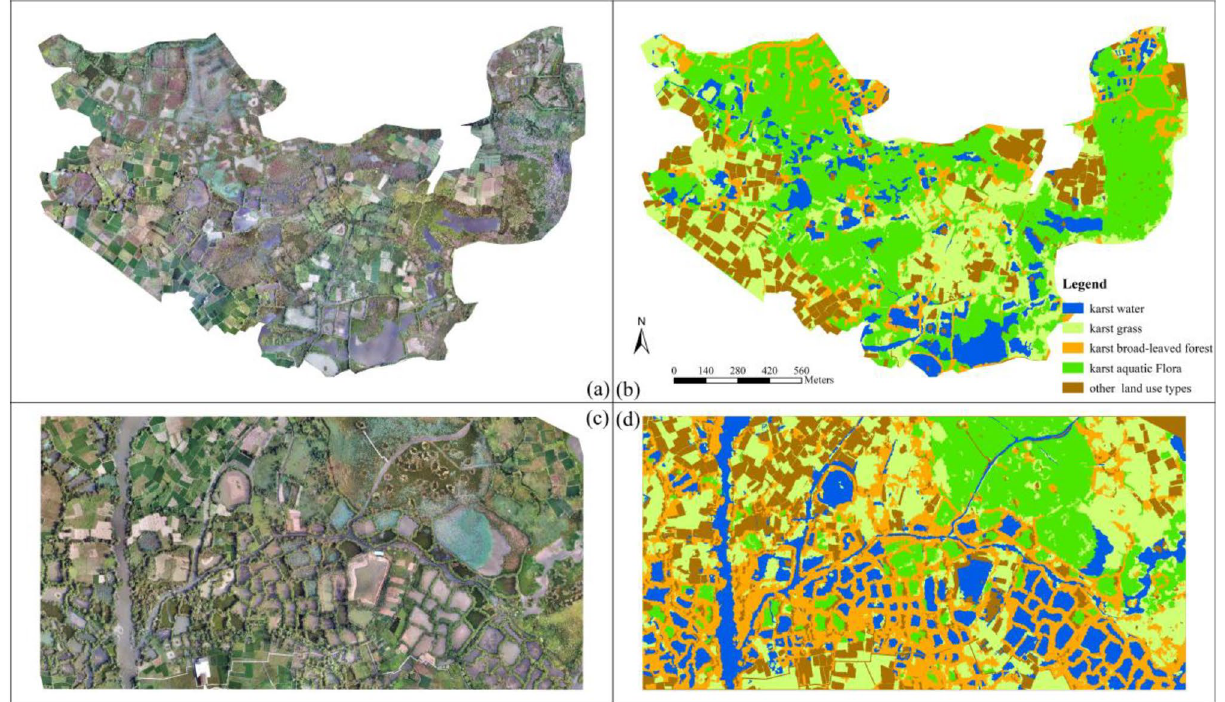
Figure 3. The semantic labeling dataset for SegNet classification ( a ) DOM image of area A. ( b ) semantic labeling dataset of Area A, 10,550*5320 pixels. ( c ) DOM image of area B. ( d ) semantic labeling dataset of area B, 11,290*7176 pixels.). ArcGIS 10.6 software (http:// www. esri. com/ softw are/ arcgis) was used to process and map the data by first author (T. D.) and corresponding author (B. F.). The DOM images and semantic labeling dataset were collected and created by T. D. and B.